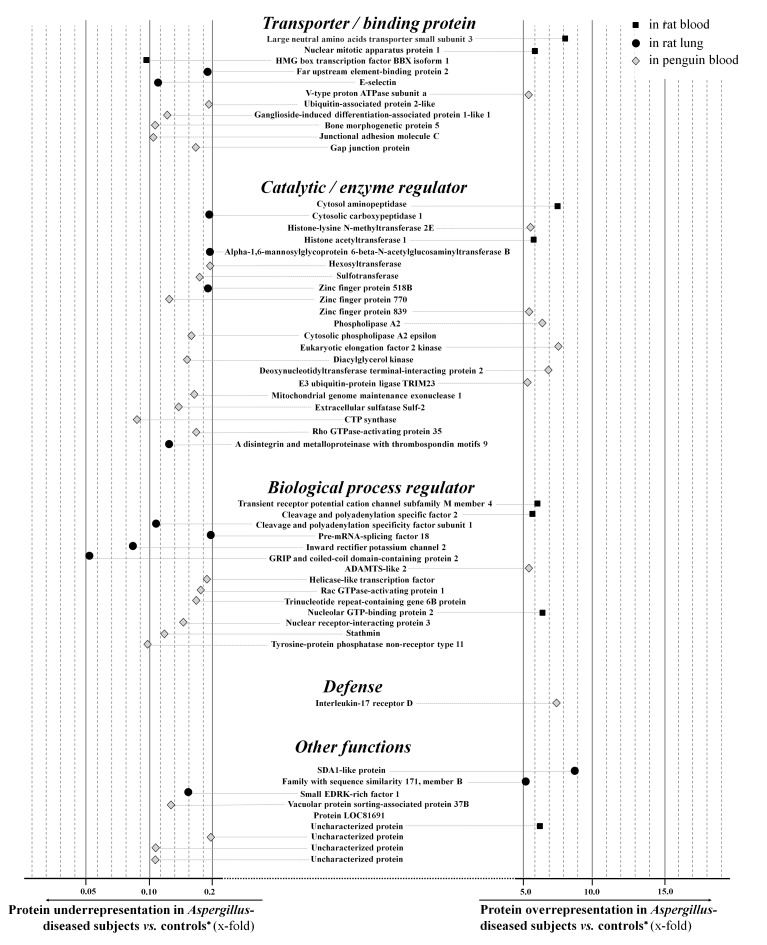
Forest plot diagram showing respective levels for the proteins that were found to be significantly overrepresented or under-represented in each animal species, in comparison with control conditions.For better clarity, only the very abundant (≥5.0-fold increased vs. controls) or very depleted proteins (≥5.0-fold decreased) are shown. Results are presented gathered according to protein functions and protein (sub-)families. * control conditions for rats: experimental challenge with bacterial lipopolysaccharide (LPS); for penguins: all the inflammatory non-Aspergillus diseases.